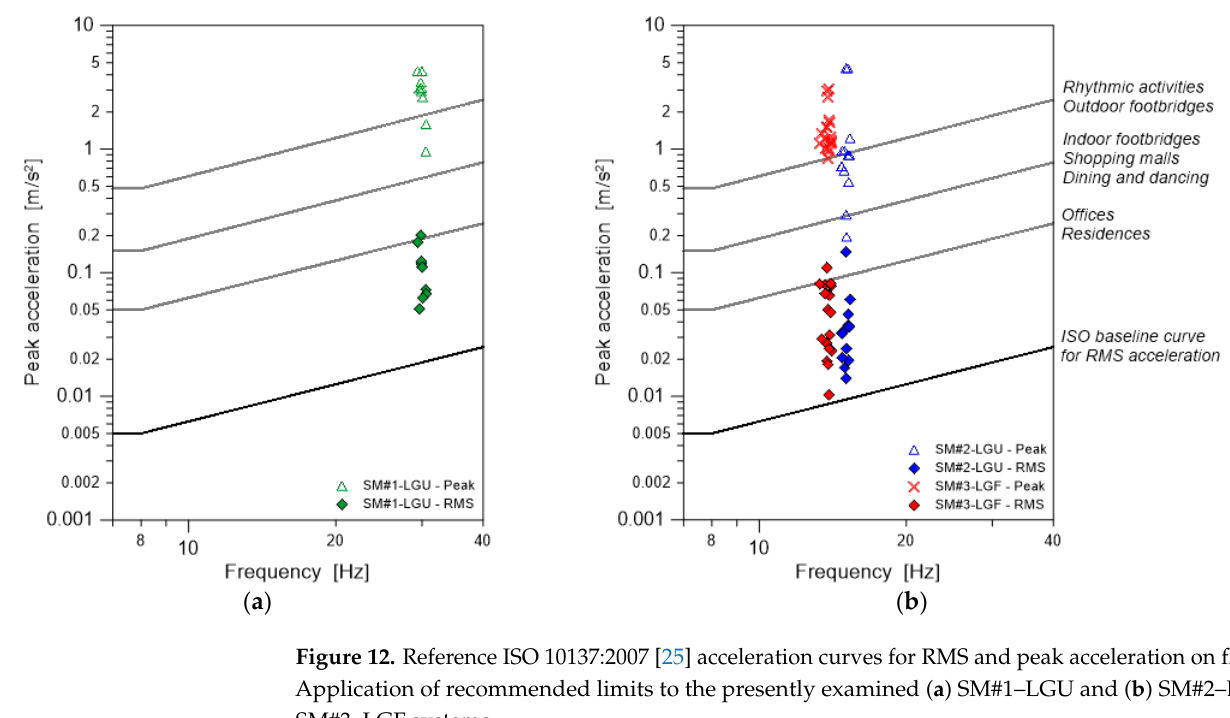
Figure 12. Reference ISO 10137:2007 [25] acceleration curves for RMS and peak acceleration on floors. Application of recommended limits to the presently examined ( a ) SM#1–LGU and ( b ) SM#2–LGU, SM#3–LGF systems. Table 4. Reference limit multiplying factors (MF) and experimentally derived MF values (Equation (14)) for continuous and intermittent vibrations, based on ISO 10137:2007 [25] (*) from Equation (9) and experimental signals; (**) from Equation (13) and ISO baseline curve.